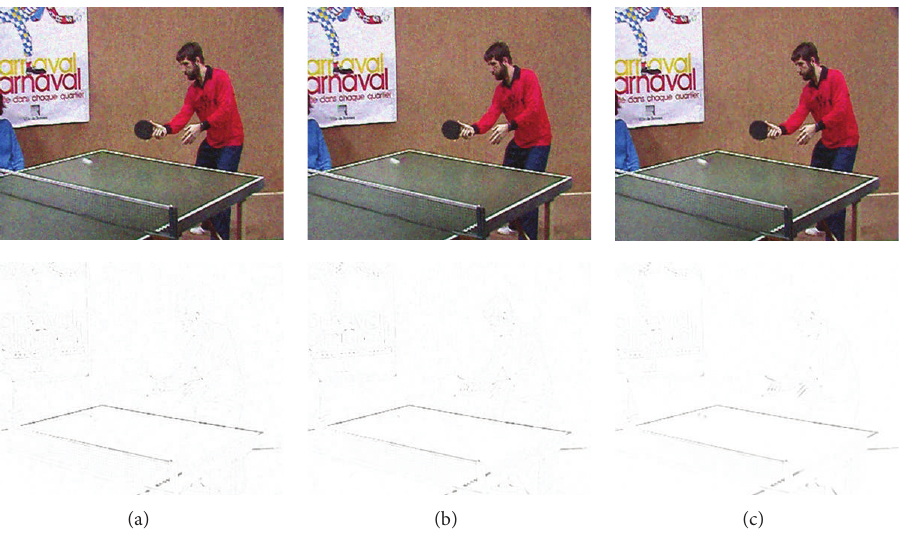
Figure 9: Filtered 81st frame of Tennis video (first row) and respective error images (second row) in case of 𝜎 2 = 0.020 noise intensity of additive noise: NLM [52] (a), VBM3D [50] (b), and FMANS 3D (c) filters. The value of each error pixel is amplified 3 times in order to distinguish the